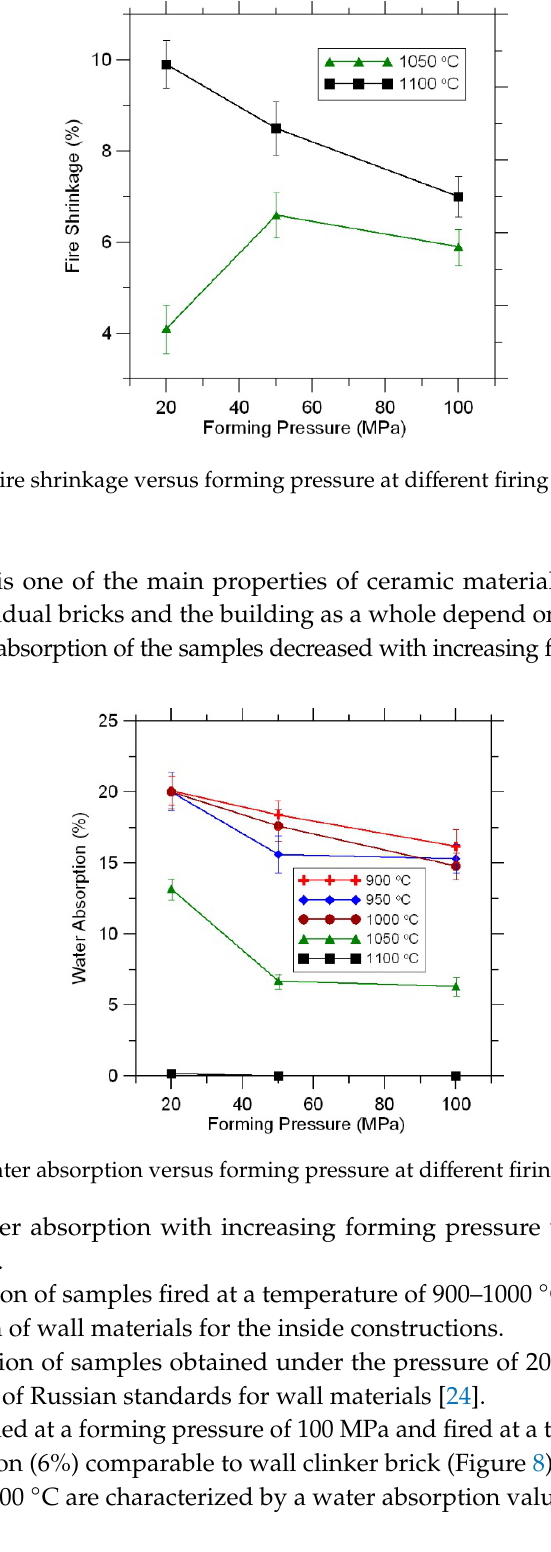
Figure 8. Water absorption versus forming pressure at different firing temperatures.